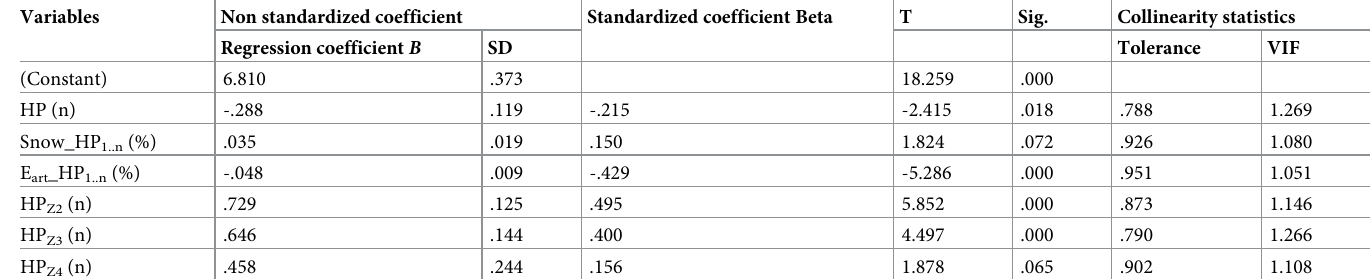
Table 3. Result of the backward stepwise linear regression, including only eye-tracking predictors with tolerance > 0.1 and variance inflation factor (VIF) < 10 dur- ing collinearity diagnostics. Only variables with p < 0.1 are shown.